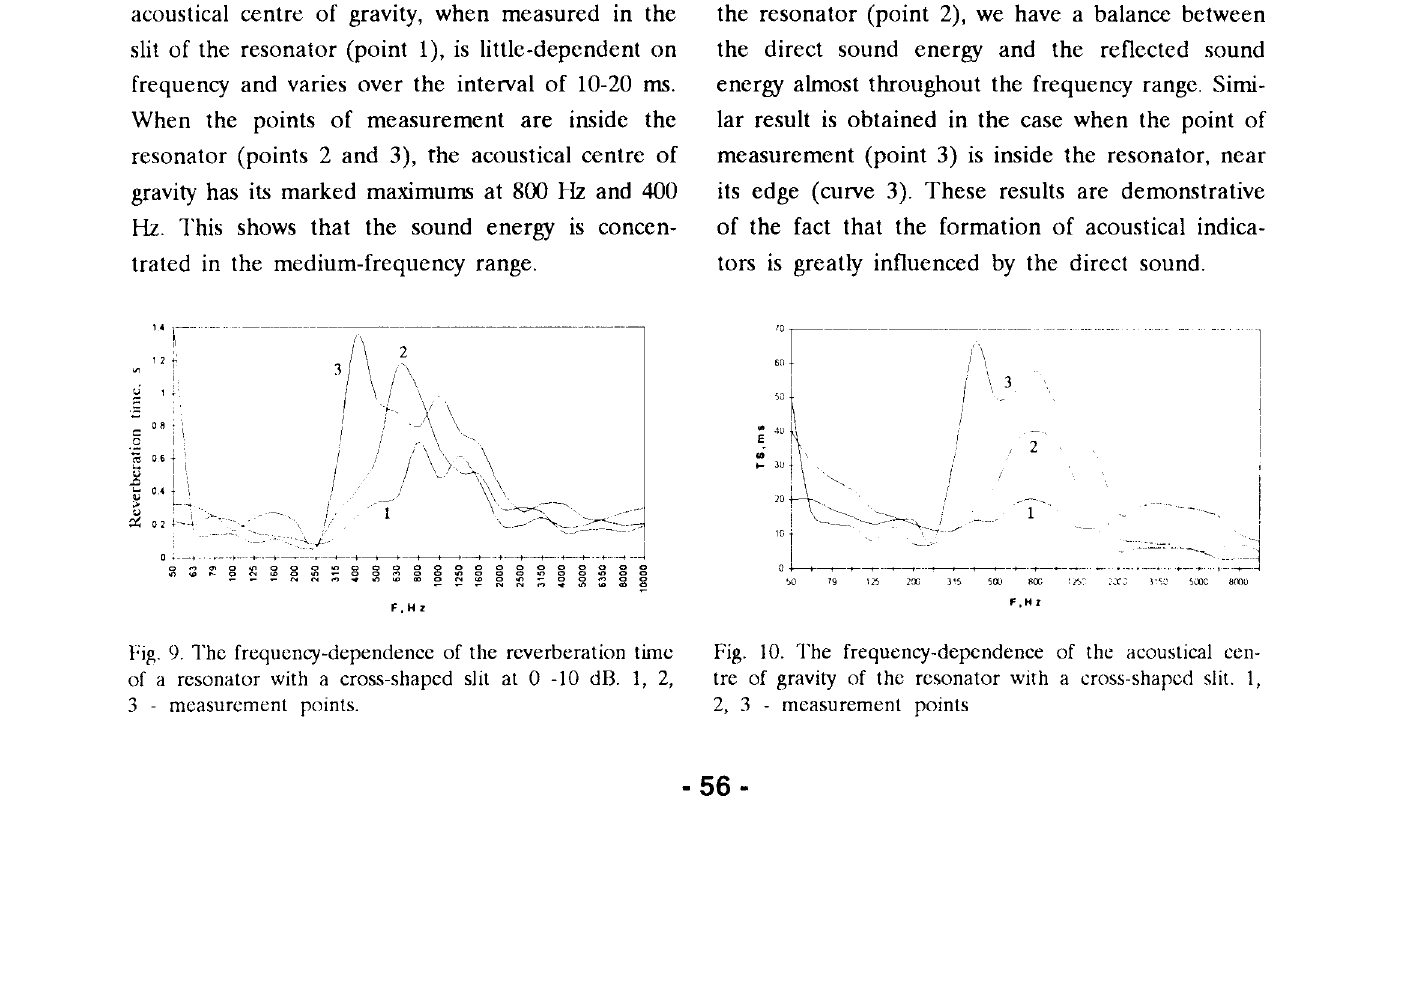
Fig. 9. The frequency-dependence of the reverberation time of a resonator with a cross-shaped slit at 0 -I 0 dB. I, 2, 3 - measurement points.